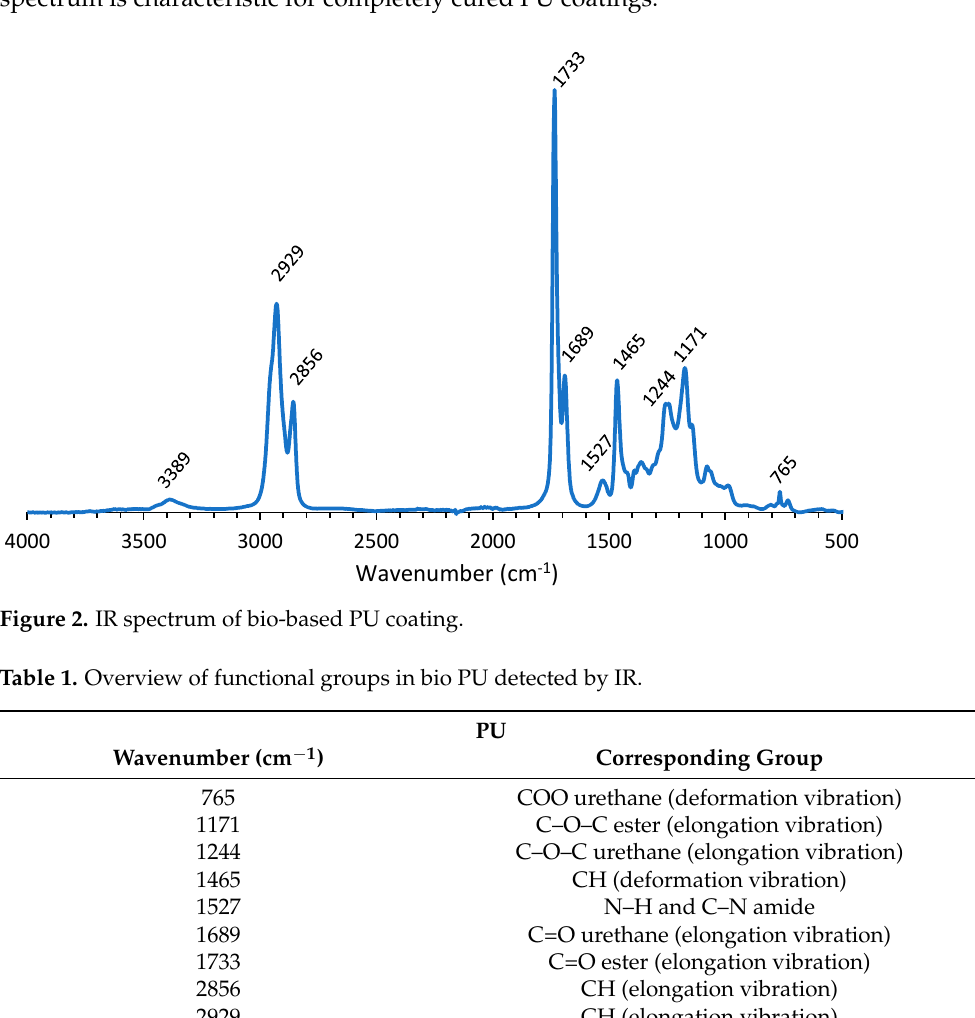
Table 1. Overview of functional groups in bio PU detected by IR.